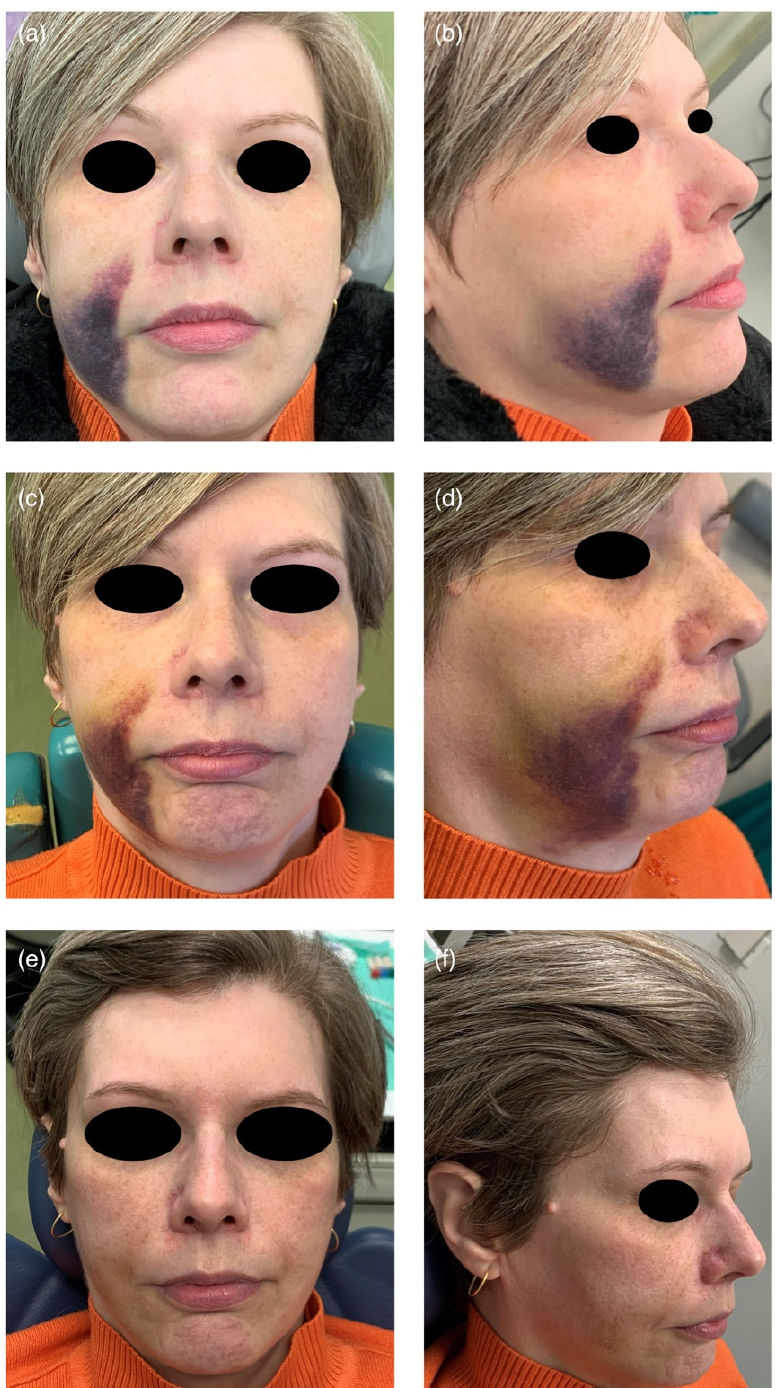
Figure 3. Second case: extraoral clinical manifestations of NaOCl Accident. ( a , b ) Day 1. ( c , d ) Day 3. ( e , f ) Day 5.